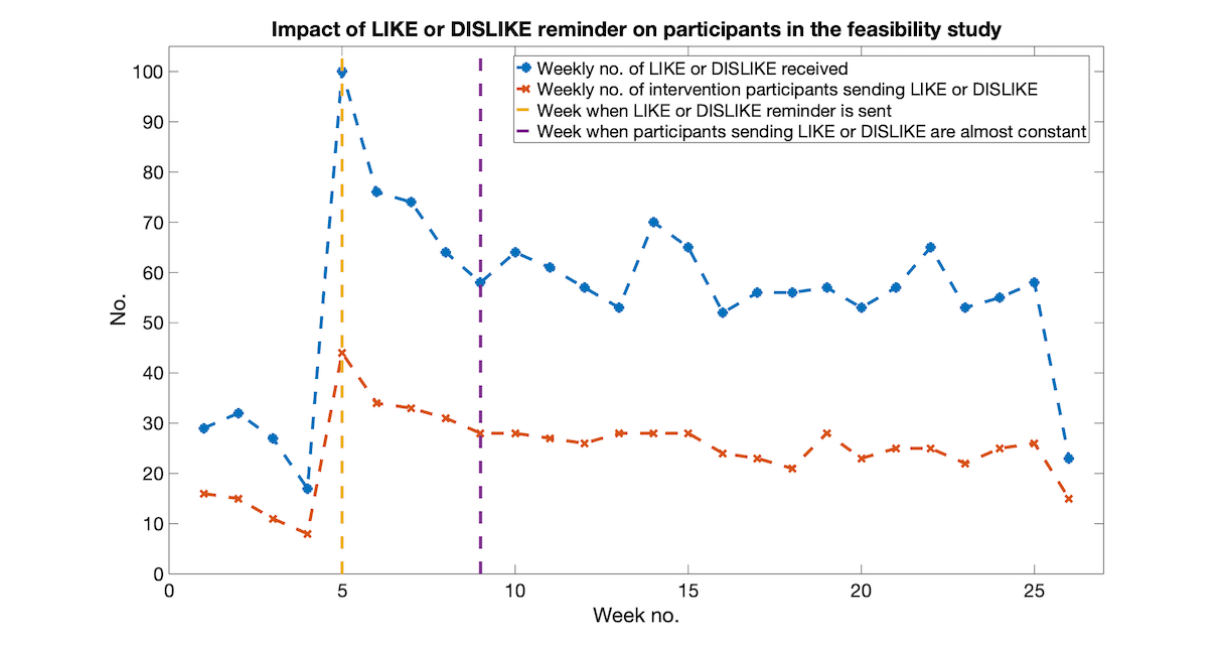
Figure 6. Impact of Like/Dislike reminder on participants in the feasibility